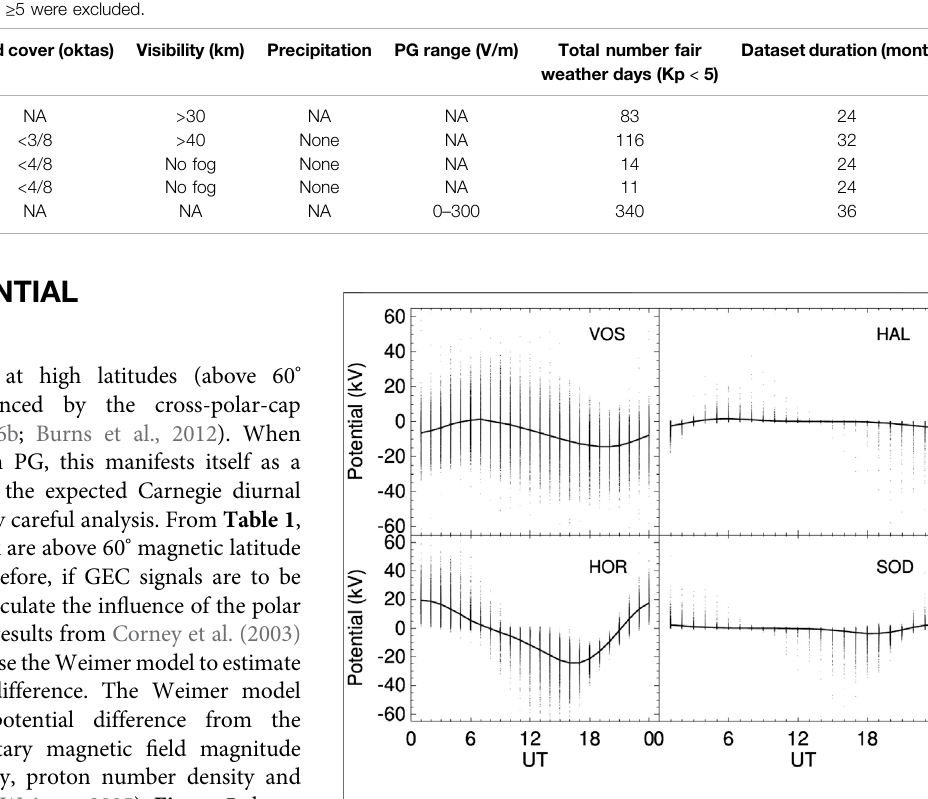
FIGURE 5 | Weimer model predictions of the high-latitude electric potentials for VOS (MLAT: 83.6 ° S; period: 2006 – 2008), HAL (MLAT: 62.3 ° S; period: 2015 – 2016), HOR (MLAT: 74.0 ° N; period: 2017 – 2019) and SOD (MLAT: 64.1 ° N; period: 2017 – 2019). The points are the individual hours and the solid line is the average